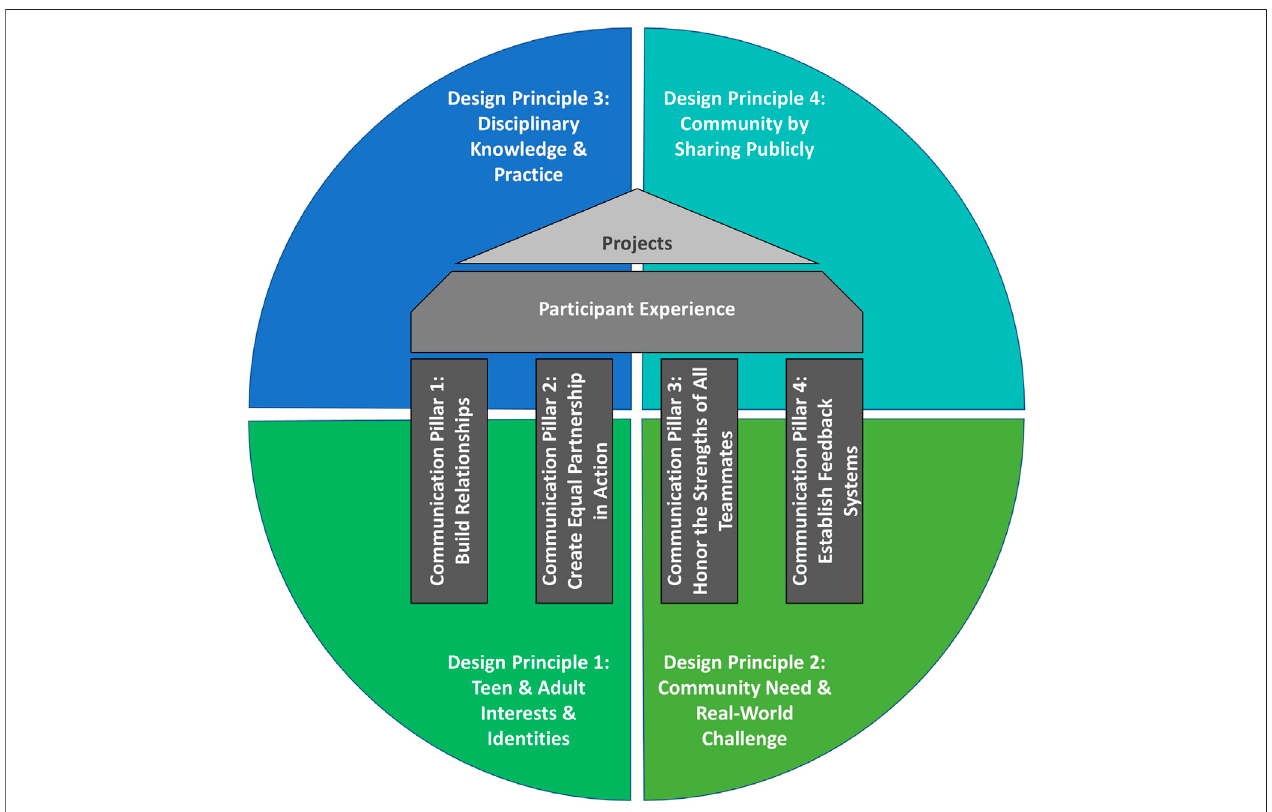
FIGURE 3 | Diagram of our program design principles and communication pillars that facilitate collaborative intergenerational community conservation projects. The principles and pillars serve dual functions ofguiding program features and providing participant support. As such, the four design principles (underlying circle) guide all our program strategies. The four communication pillars support the positive experiences of our participants by disrupting traditional uneven power structures in intergenerational partnerships and providing strategies for collaborative team norms, thus allowing all teammates to engage in conservation work more deeply